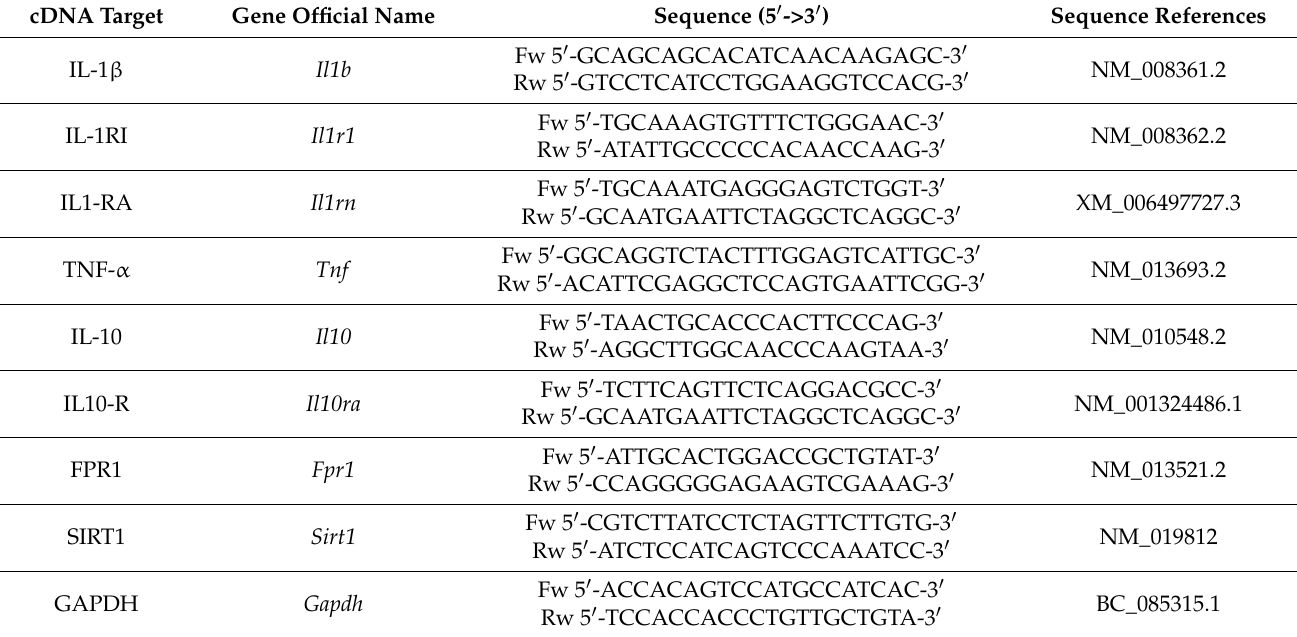
Table 1. Primer sequences for the tested